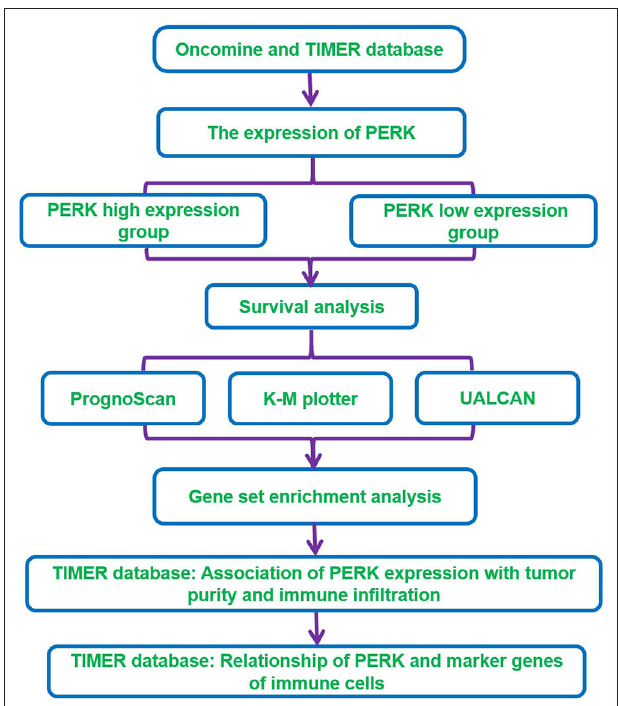
FIGURE 1 | The workflow chart of the study design and